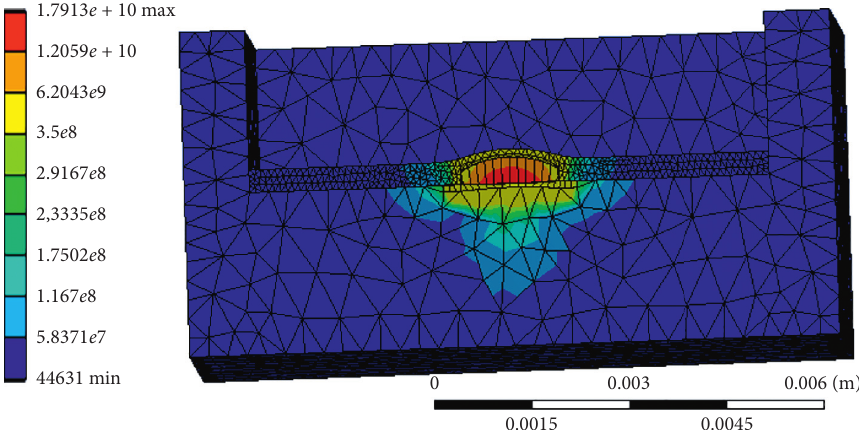
Figure 7: Pressure distribution of static simulation